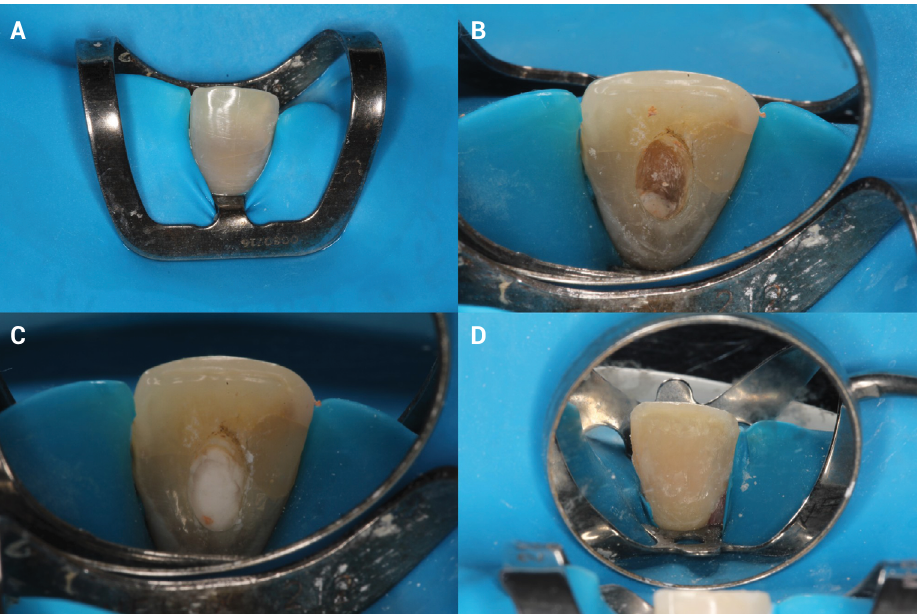
Figure 1. Clinical protocol of internal bleaching. (A) Rubber-dam isolation and removal of all restorative material; (B) Removal of the MTA and insertion of 2mm of Coltosol as a cervical barrier; (C) Insertion of the bleaching agent; (D) Temporary restoration with composite